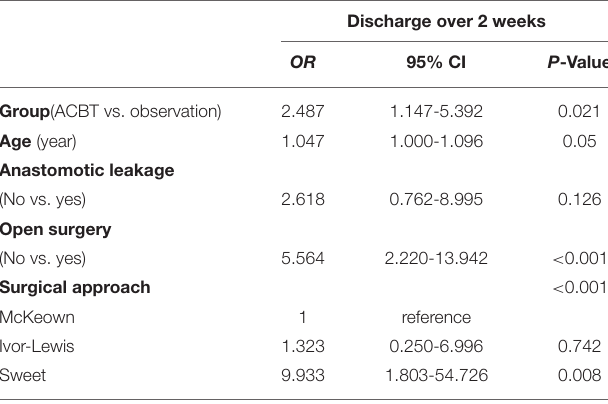
TABLE 3 | Multivariable Logistic regression analysis for length of hospital stay according to different groups in all